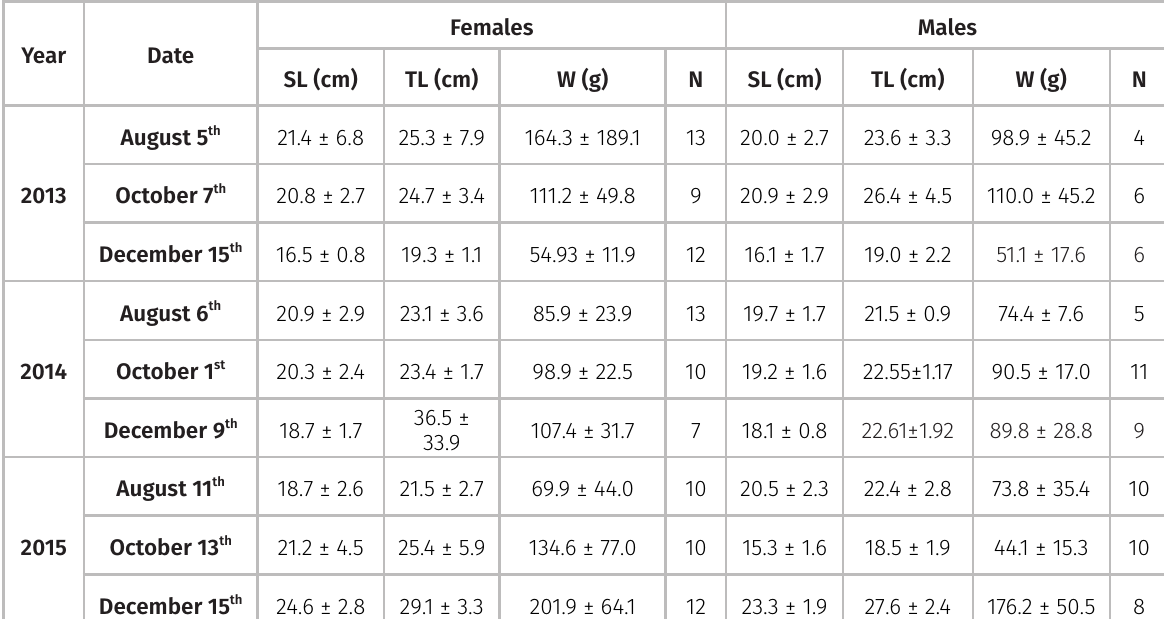
Table I. Morphometric data of pejerrey captured in Gomez